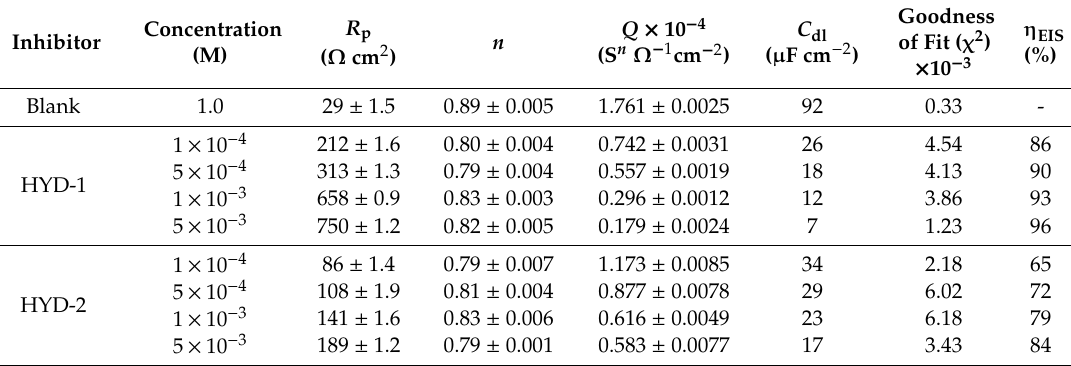
Table 4. Electrochemical impedance spectroscopy (EIS) parameters derived after curve fitting in the absence and presence of several concentrations of HYD-1 and HYD-2 at 303 K.